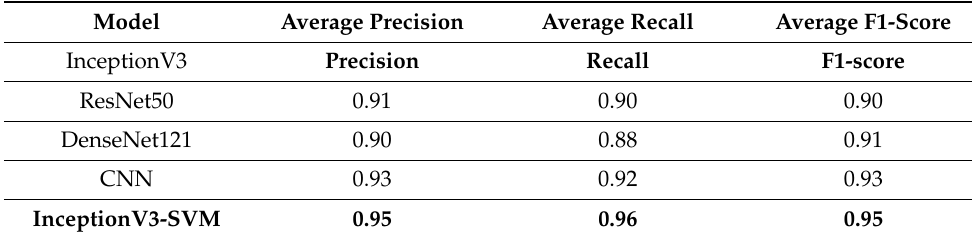
Table 8. Model Average Performance